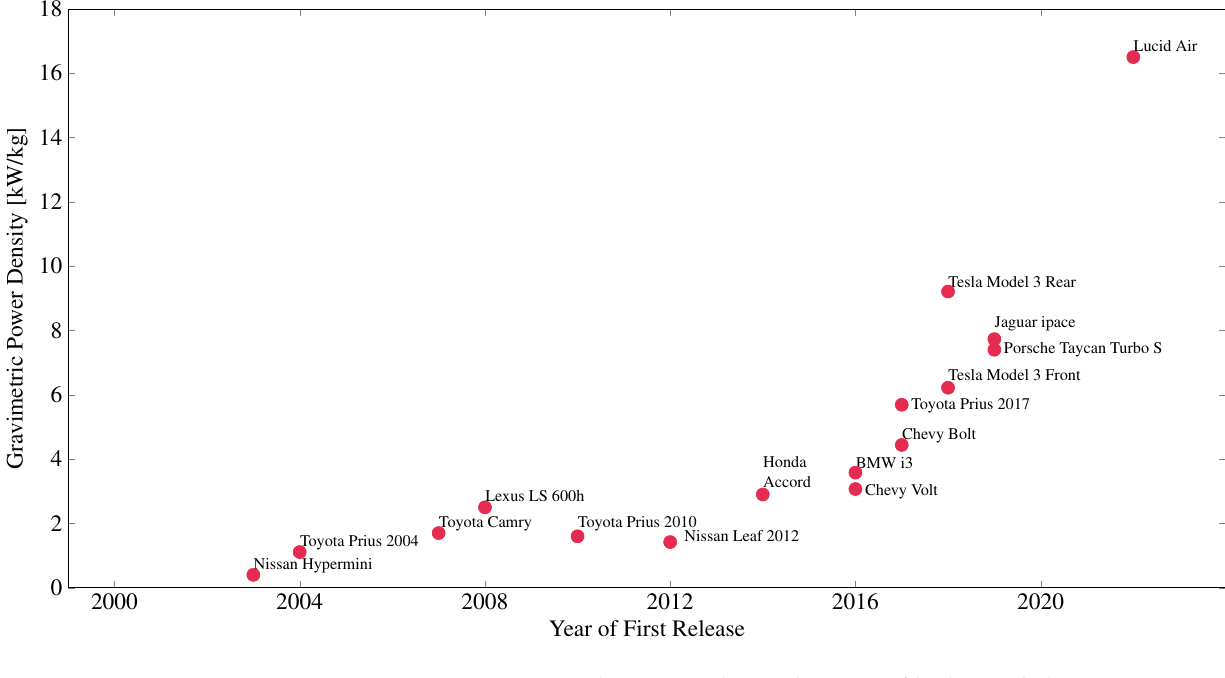
Figure 2. Gravimetric power density trend over the years of high-speed electric motors used in EVs [4,19–21]. Table 1. Specifications of commercially central-motor drives for electric traction